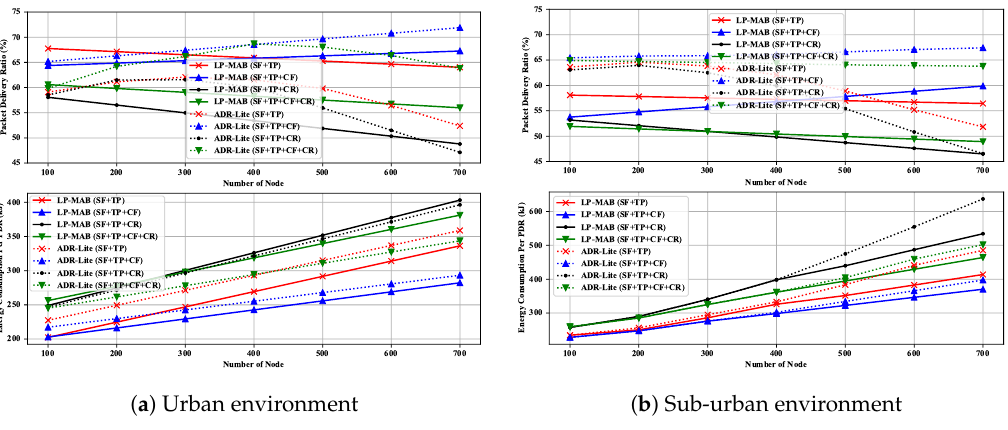
Figure 15. PDR & EC versus different values for number of total actions in Scenario